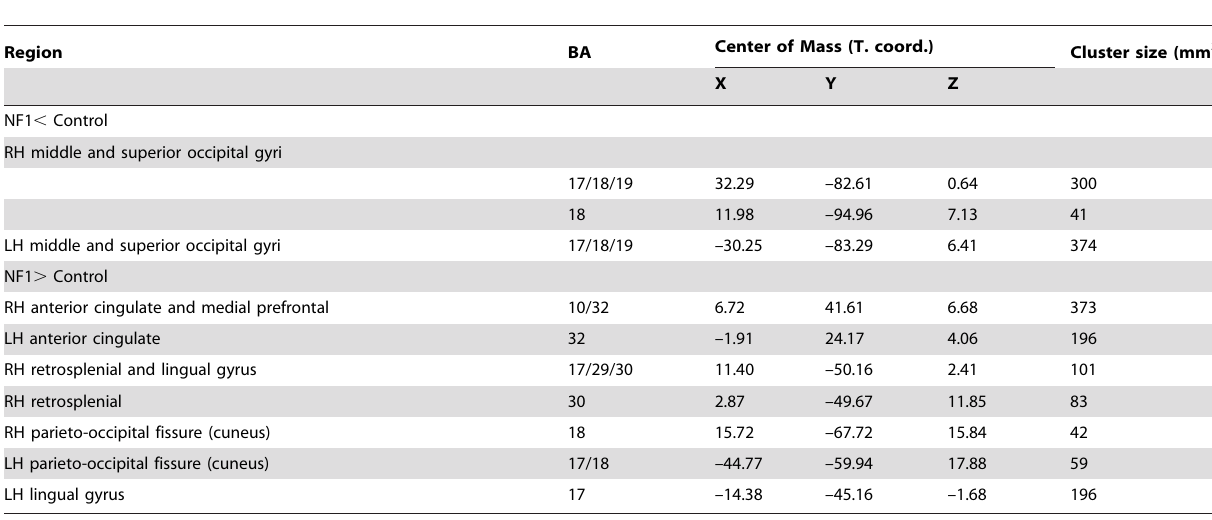
Table 2. Localization and cluster size of the regions with significant between-group differences in activation during M-biased stimulation for the overall (children and adults) groups.